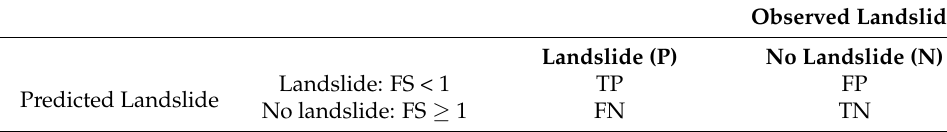
Observed Landslide Landslide (P) No Landslide (N)